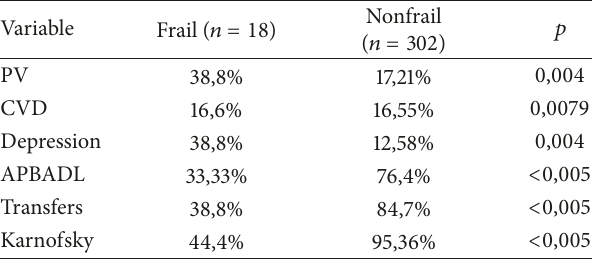
Table 3: Associated comorbidities of frail versus nonfrail patients.